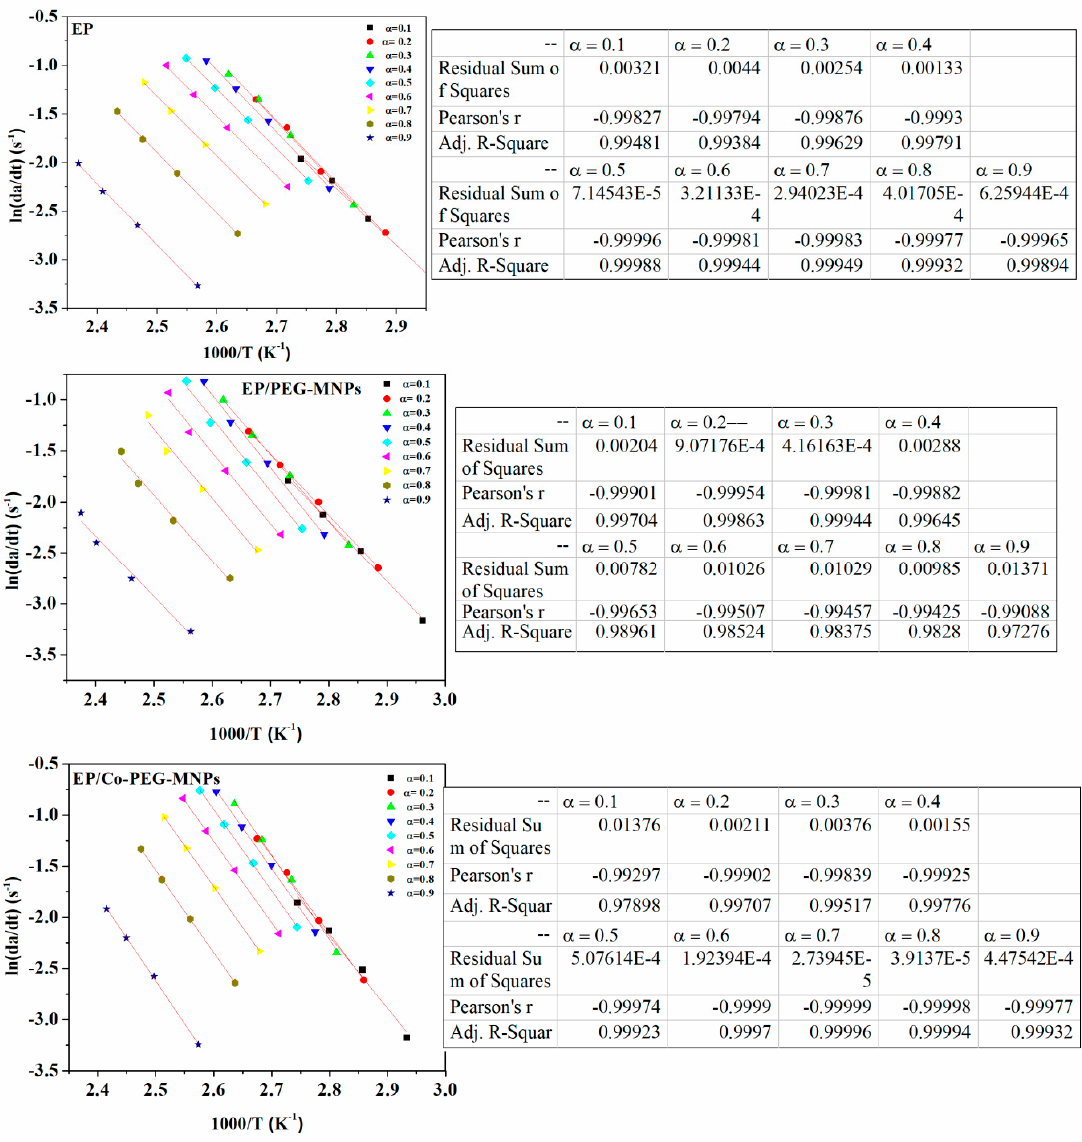
( ) 2 α ,ii T β ln vs. 1/ T α from Equation (8) for each α value gives a value for E α (Figure A2).